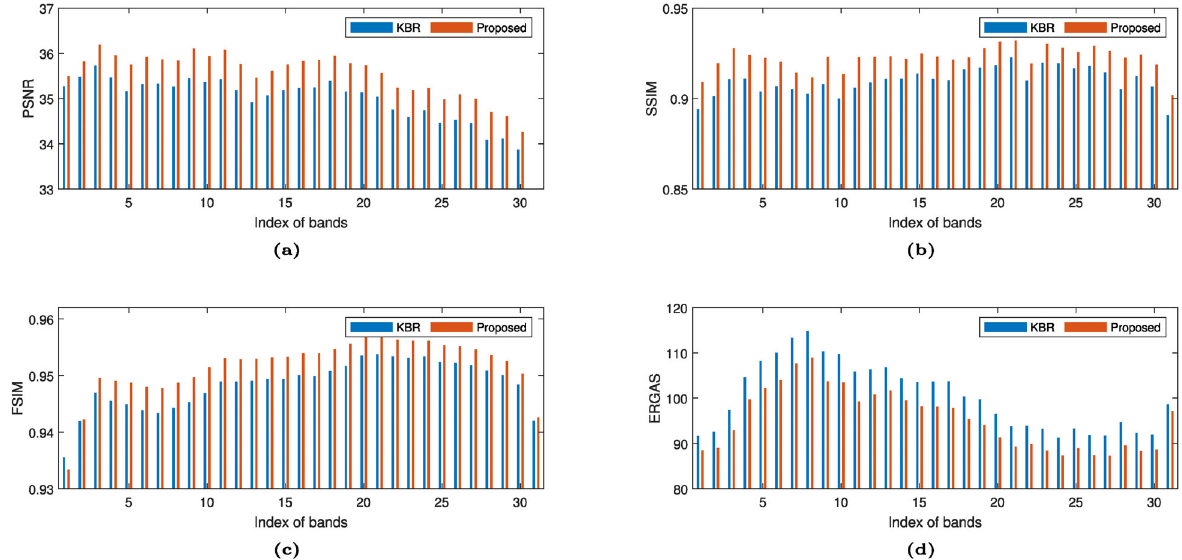
Fig. 5 Image quality index versus band index for KBR [16] and the proposed method. The results were obtained by averaging over all the combinations of 32 scenes and 6 levels of noise. (a) PSNR; (b) SSIM; (c) FSIM; (d) EGRAS, computed on each band separately, degenerating to a quality index of each grayscale